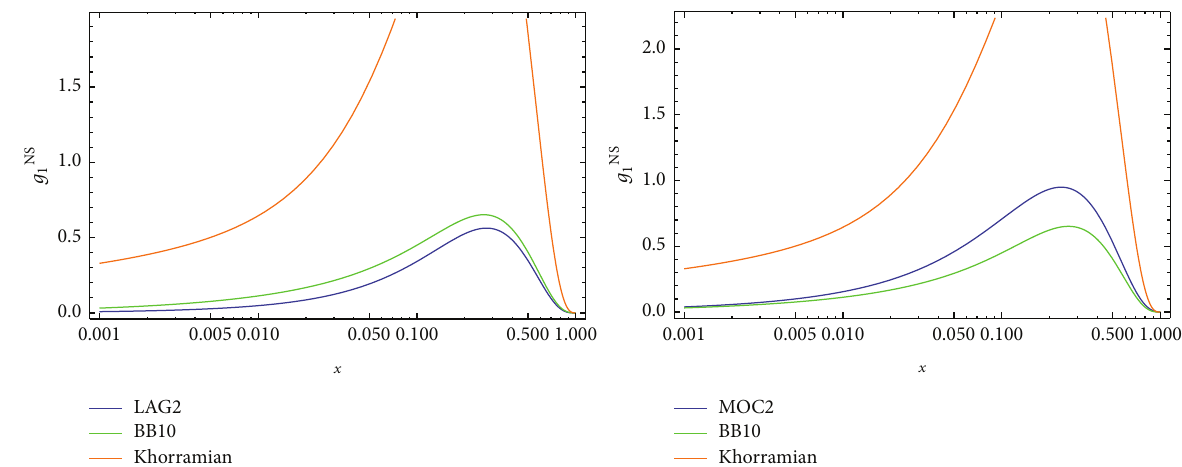
Figure 2: Polarized nonsinglet structure function 𝑔 NS 1 (𝑥,𝑡) as function of 𝑥 at 𝑄 2 = 4 GeV 2 at NLO, resulting, respectively, from our analytical calulations and their comparison with global fits to test the accuracy of our calculation.